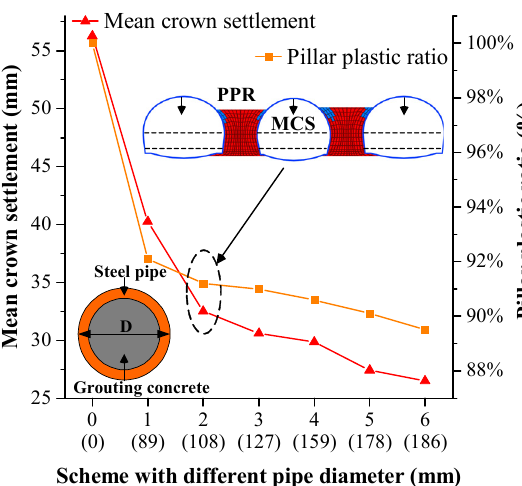
Figure 11. E ff ect of pipe diameter on mean crown settlement (MCS) and pillar plastic ratio Figure 11. Effect of pipe diameter on mean crown settlement (MCS) and pillar plastic ratio (PPR, red elements represent plastic zone).